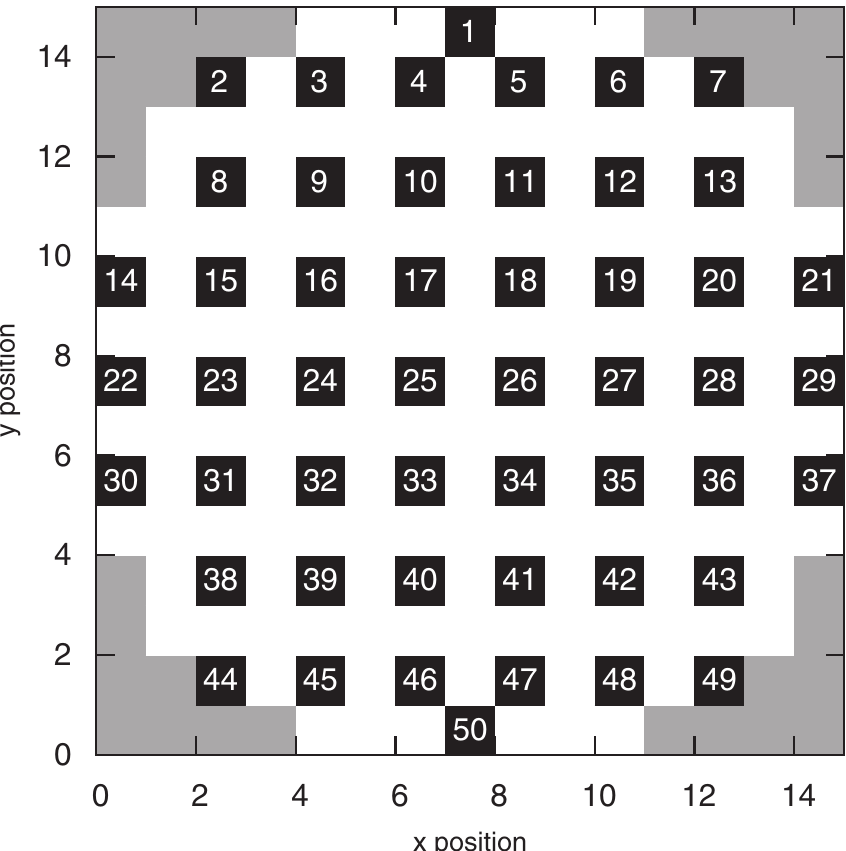
Fig. 2. The Thermocouples (TC) instruments within the nuclear core are localised above assemblies in black, in a horizontal slice of the core. The assemblies without instrument are marked in white, and the re fl ector is in